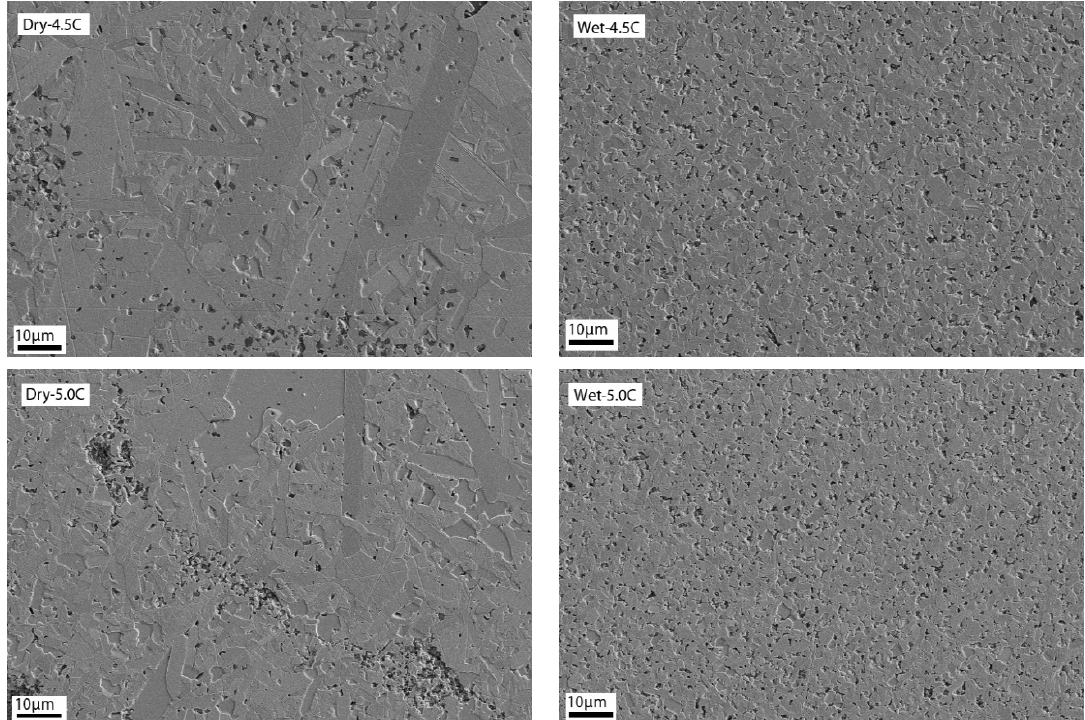
Figure 1. Field emission scanning electron microscope (FESEM) images for dry mixed–wet mixed SiC ceramics. Table 2. The density, average grain size, and elastic modulus of dry mixed–wet mixed dense SiC. Average Grain Size (std. dev.) E (GPa) Density (g / cm 3 ) ( µ m)